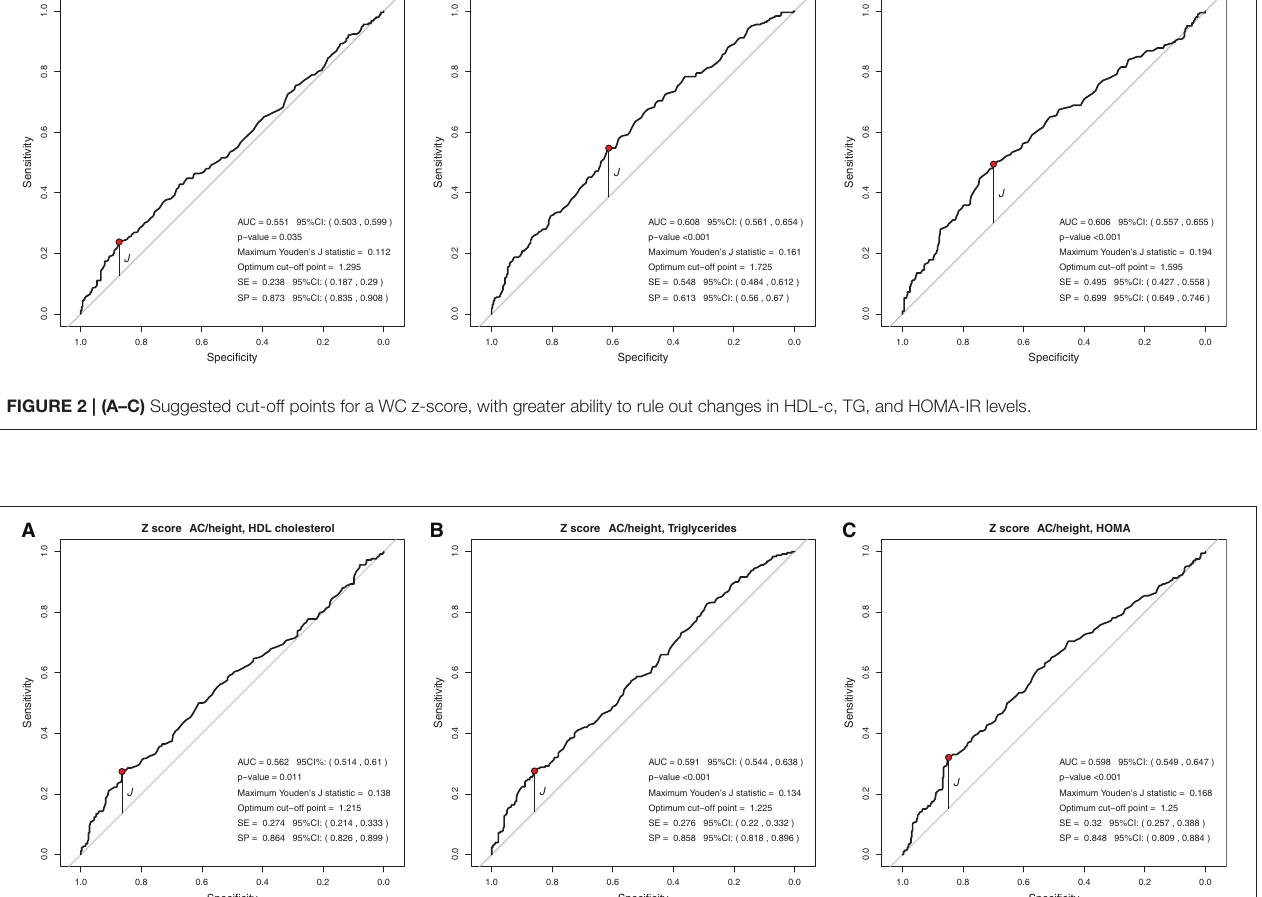
FIGURE 3 | (A–C) Suggested cut-off points for the WC/H z-score, with greater ability to rule out changes in HDL-c, TG, and HOMA-IR levels.